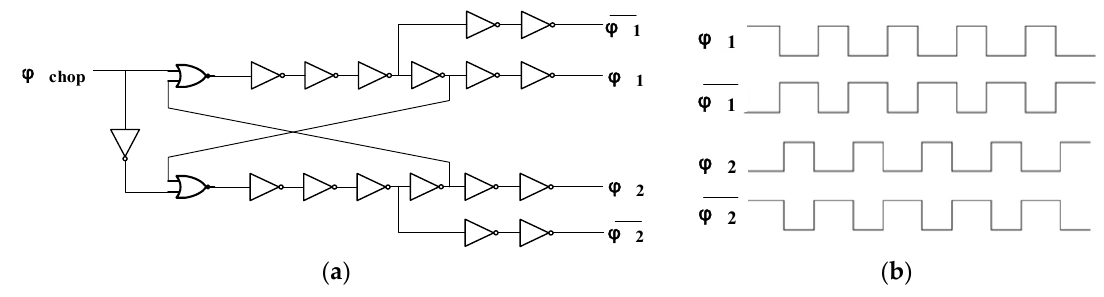
Figure 5. ( a ) Non-overlapping clock generator; ( b ) Non-overlapping clock signals.